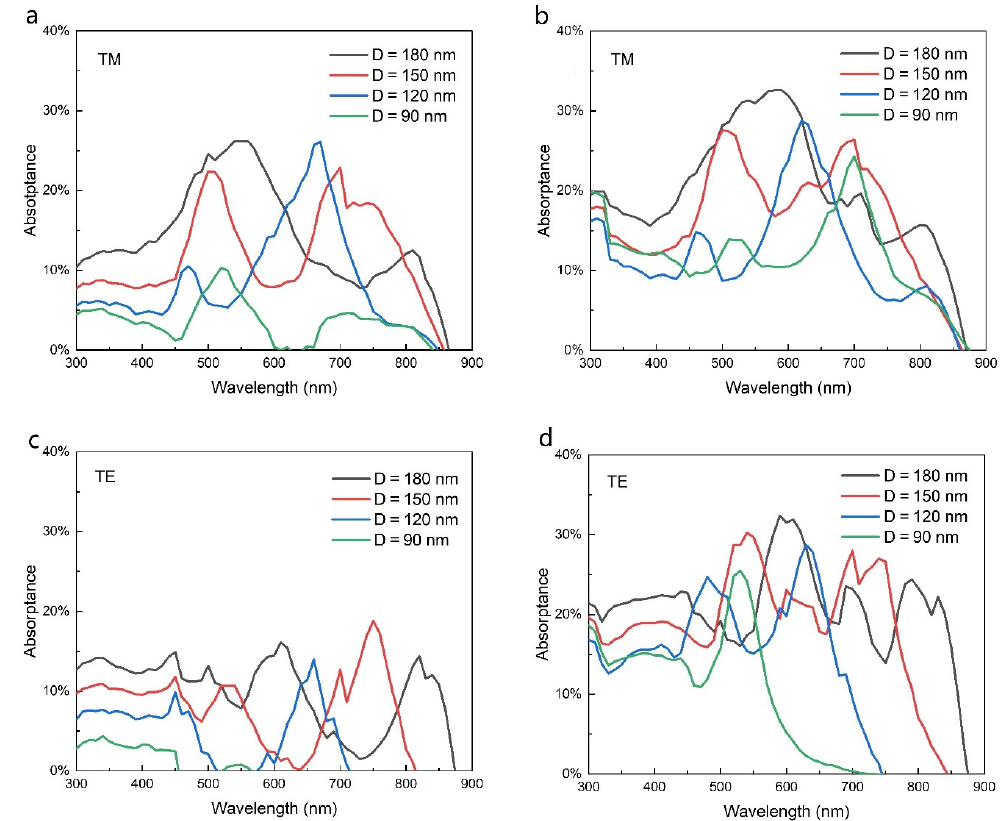
Figure 5. Dependence of the absorptance of NWs on their diameter. ( a , b ) Absorptance of TM light for NW without and with gratings, respectively; ( c , d ) absorptance of TE light for NW without and with gratings, respectively. The grating period is 400 nm.